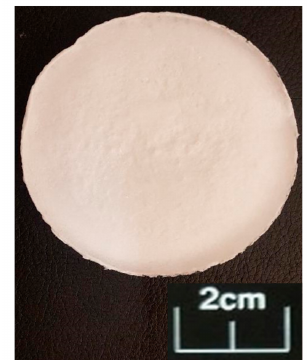
Figure 4. Photographic appearance of the PLA-PVA porous bioscaffold.